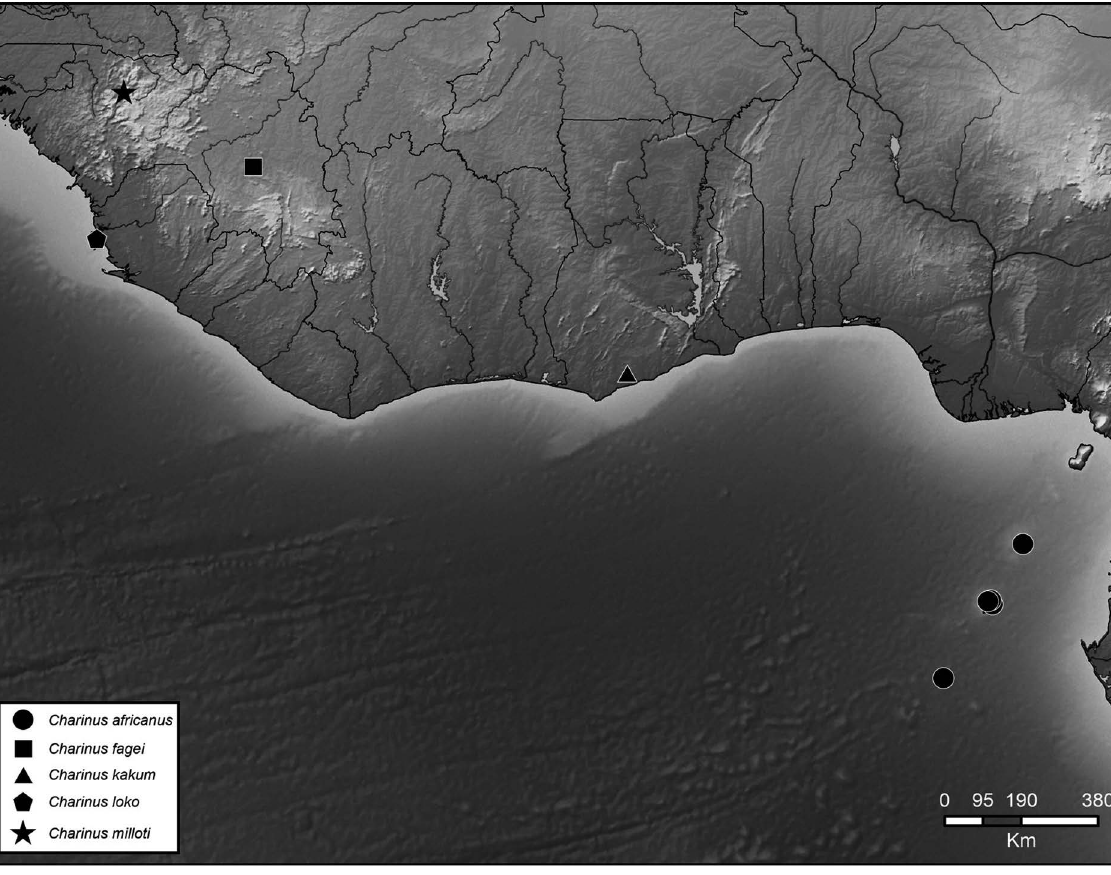
Fig. 83. Map plotting known distributions of species of Charinus Simon, 1892 in western